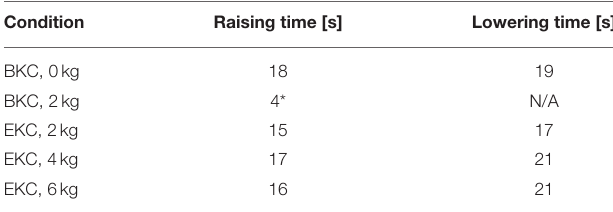
Frontiers in Robotics and AI |